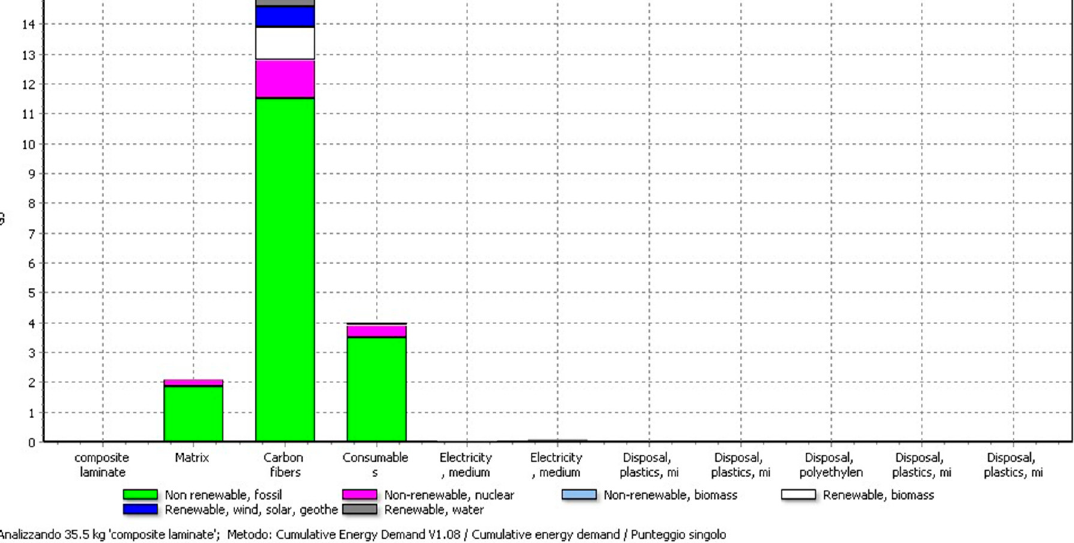
Figure 5. Electricity consumption in the CF-composite preparation. The highest contribution comes from the production of carbon fibres.